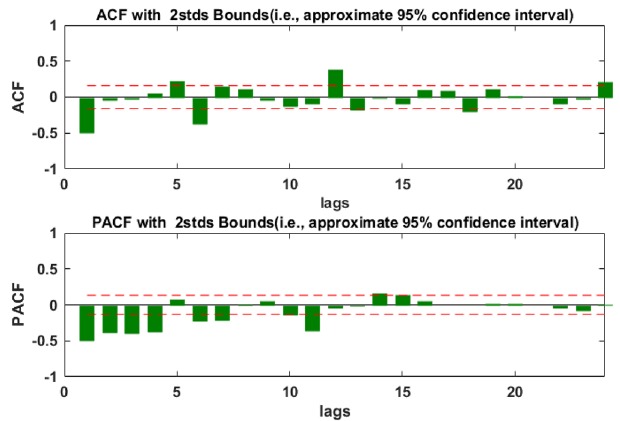
Figure 4. Autocorrelation and partial correlation diagram of electric energy production time series in Xinjiang after quadratic